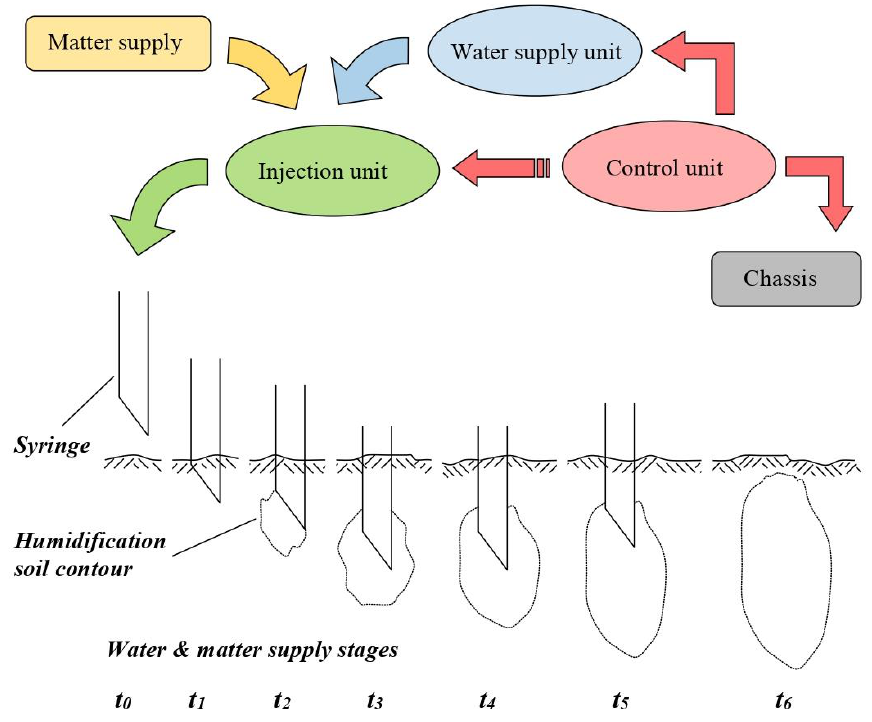
Figure 6. Intra-soil pulse continuous-discrete watering.